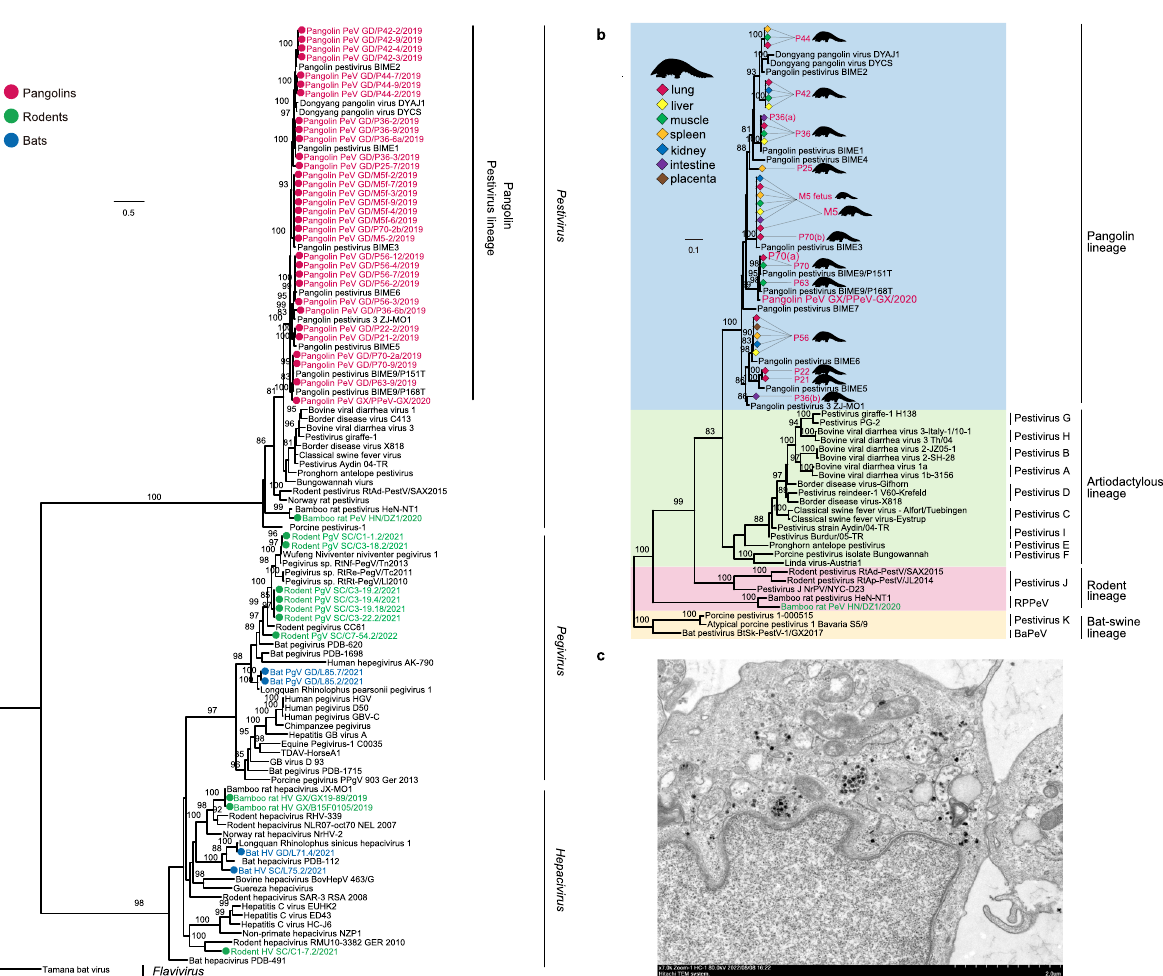
Fig. 3 | Phylogenetic diversity of fl aviviruses identi fi ed here. a Phylogeny of the Flaviviridae based on amino acid sequences of the NS5 gene. Viruses identi fi ed in thisstudyare color-codedaccording to the animalfrom which they weresampled. The tree wasrooted with Tamana batvirus. Scale bardepicts thenumber of amino acid substitutions per site. b Phylogeny of pestiviruses based on the amino acid sequencesofthe NS5 gene.RepresentativesofPestivirusA-Kareincorporated.The